Question: State the chart type depicted above.
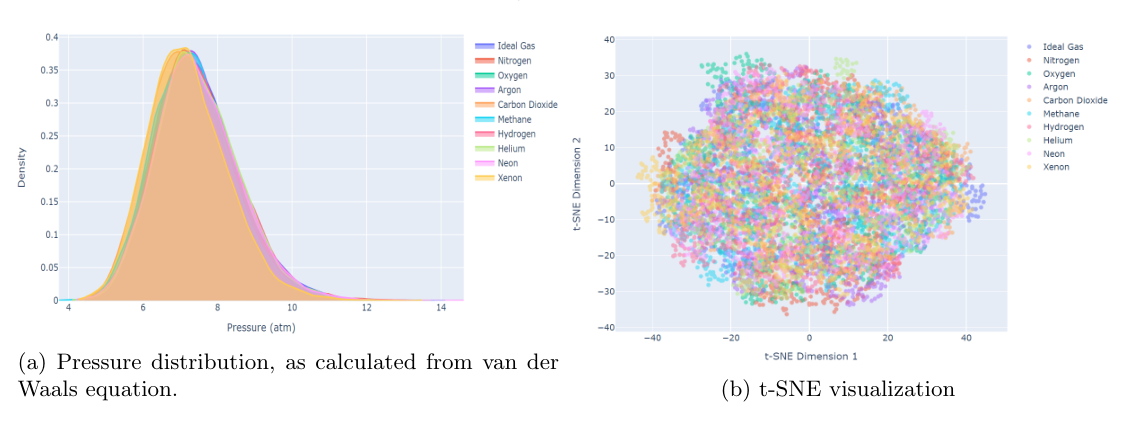
Answer: scatter